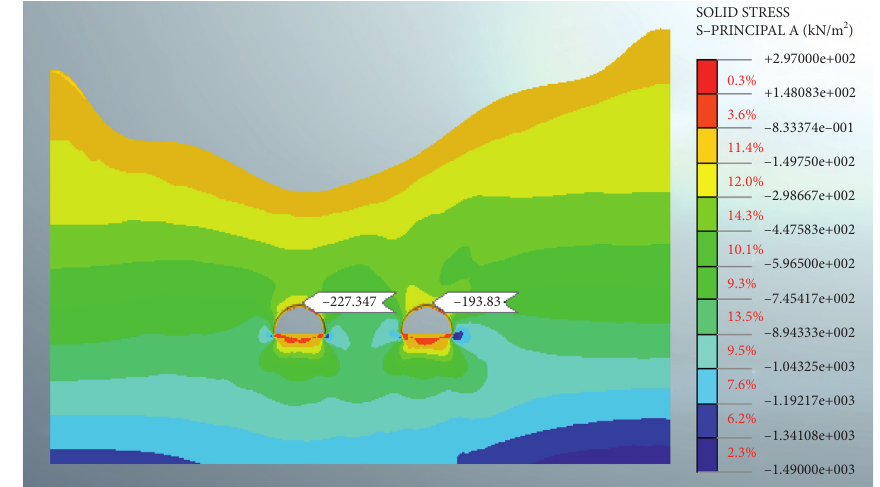
Figure 12: Distribution of small principal stresses in surrounding rocks in double-side guide pit